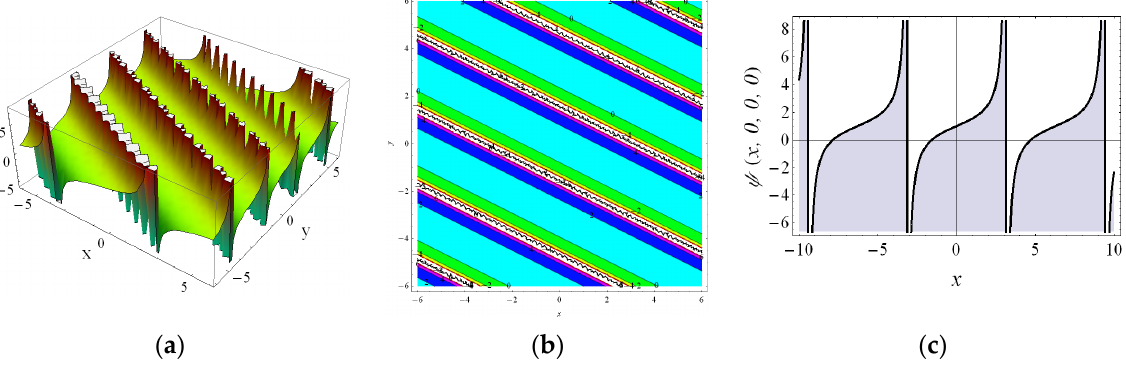
Figure 5. The 3-D plots and 2-D curve of Equation (27) with the parameters as α 0 = 1, α 1 = 1, n = 1, k = 1, and µ = − 1. ( a ) 3-D plot for z = 0 and t = 0, ( b ) 2-D contour for z = 0 and t = 0, and ( c ) 2-D curve for y = 0, z = 0, and t = 0.